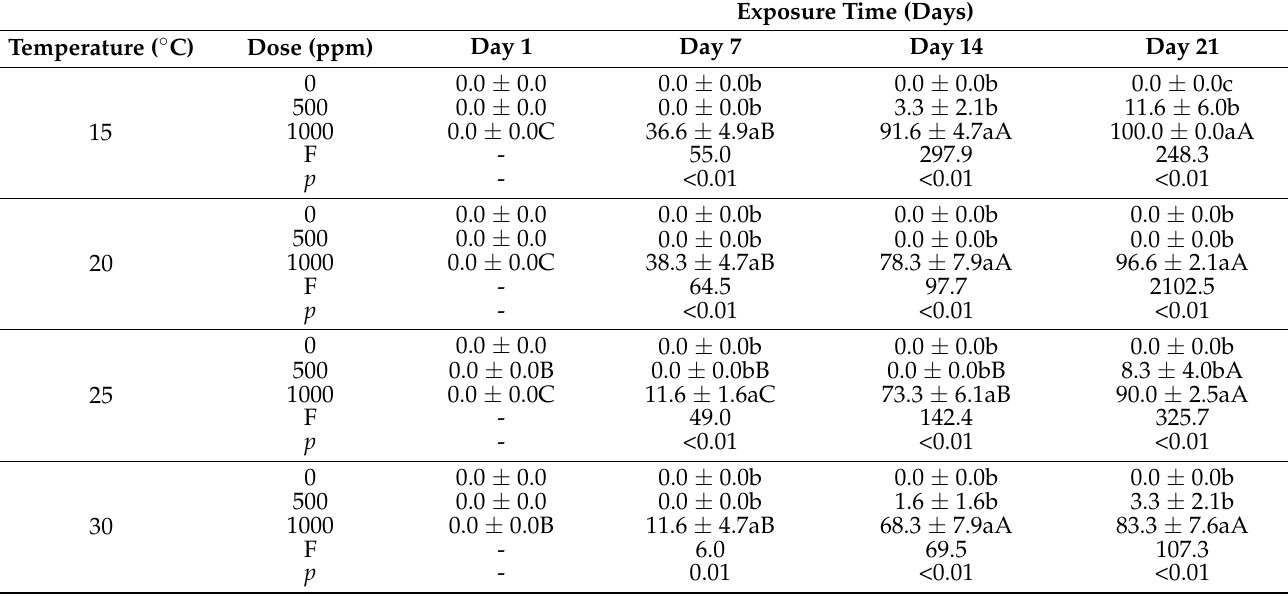
Table 7. Mean mortality (% ± SE) of T. confusum adults exposed for 1, 7, 14, and 21 days to wheat treated with three different doses of diatomaceous earth (0, 500, and 1000 ppm) and four different temperatures (15, 20, 25, and 30 ◦ C), at 75%